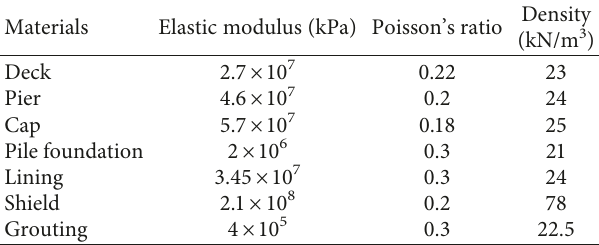
Table 3: Calculation parameters of bridge structure and materials. Materials